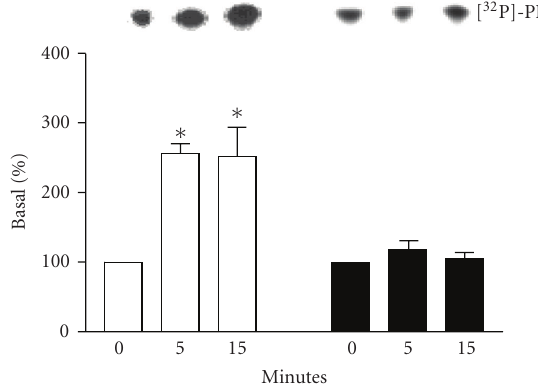
Figure 5: PI-3K activity with chimeric β -AR stimulation . HEK 293 cells were transfected with β 1 × β 2 -AR or β 2 × β 1 -AR. Forty- eight hours after transfection, cells were stimulated with 1 μ M isoproterenol for the indicated times. PI-3K activity was determined by the level of [ 32 P ]-PI produced by the stimulation of β 1 × β 2 -AR ( (cid:2) ) or β 2 × β 1 -AR ( (cid:3) ) expressing cells. Top panel is a representative autoradiograph of the TLC separation ( n = 4-5). Data from these experiments is quantitated in the bottom panel as described in Section 2. ∗ P < . 05 versus 0 minute.